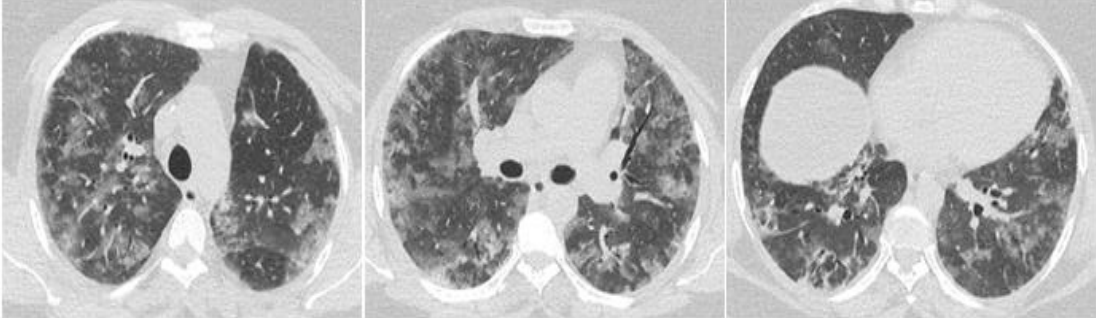
Figure 2. The chest CT scan performed at the time of sudden respiratory degradation, shows a rapidly progressive interstitial lung disease with the appearance of diffuse and extensive ground glass opacities.